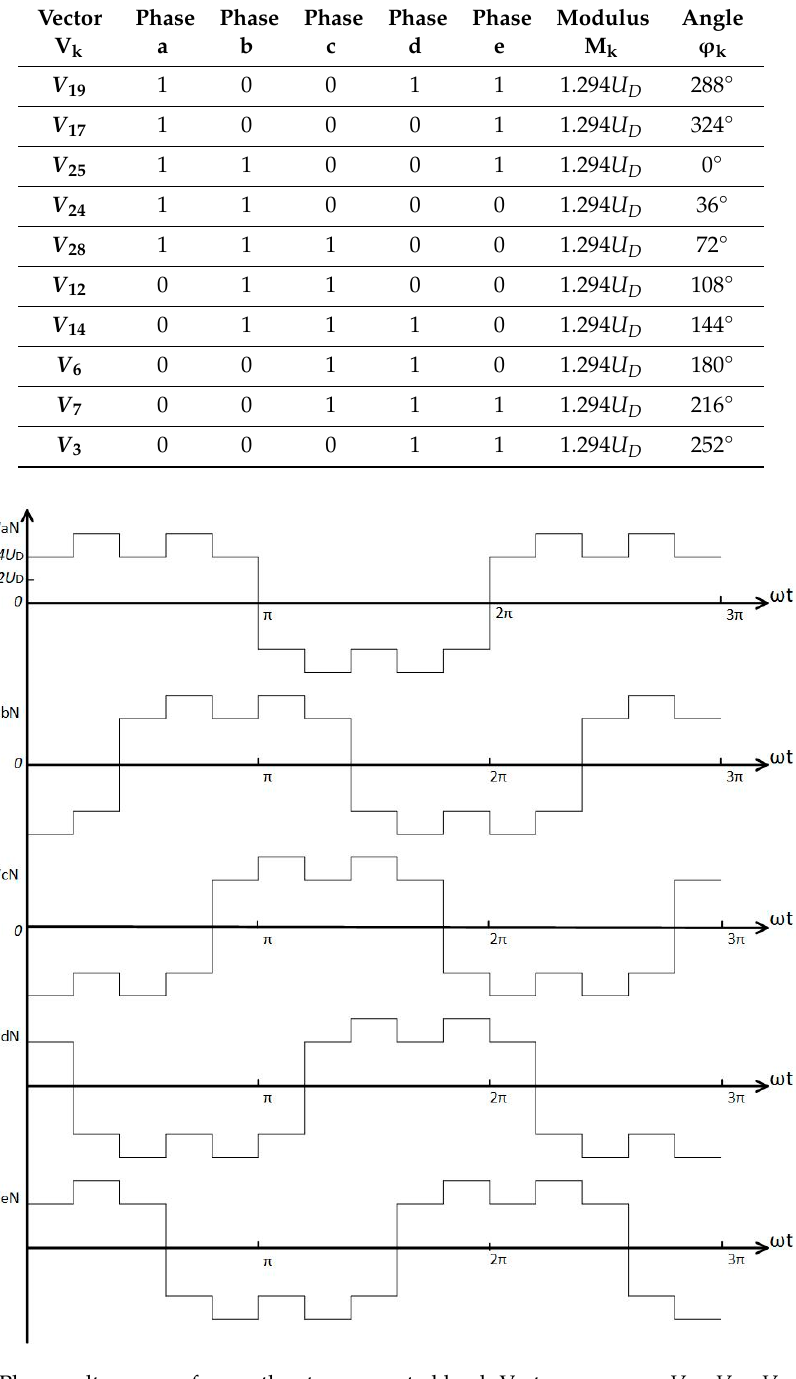
Table 3. Collected parameters of the vectors. Red color denotes potential +𝑈 (cid:3005) , green color –